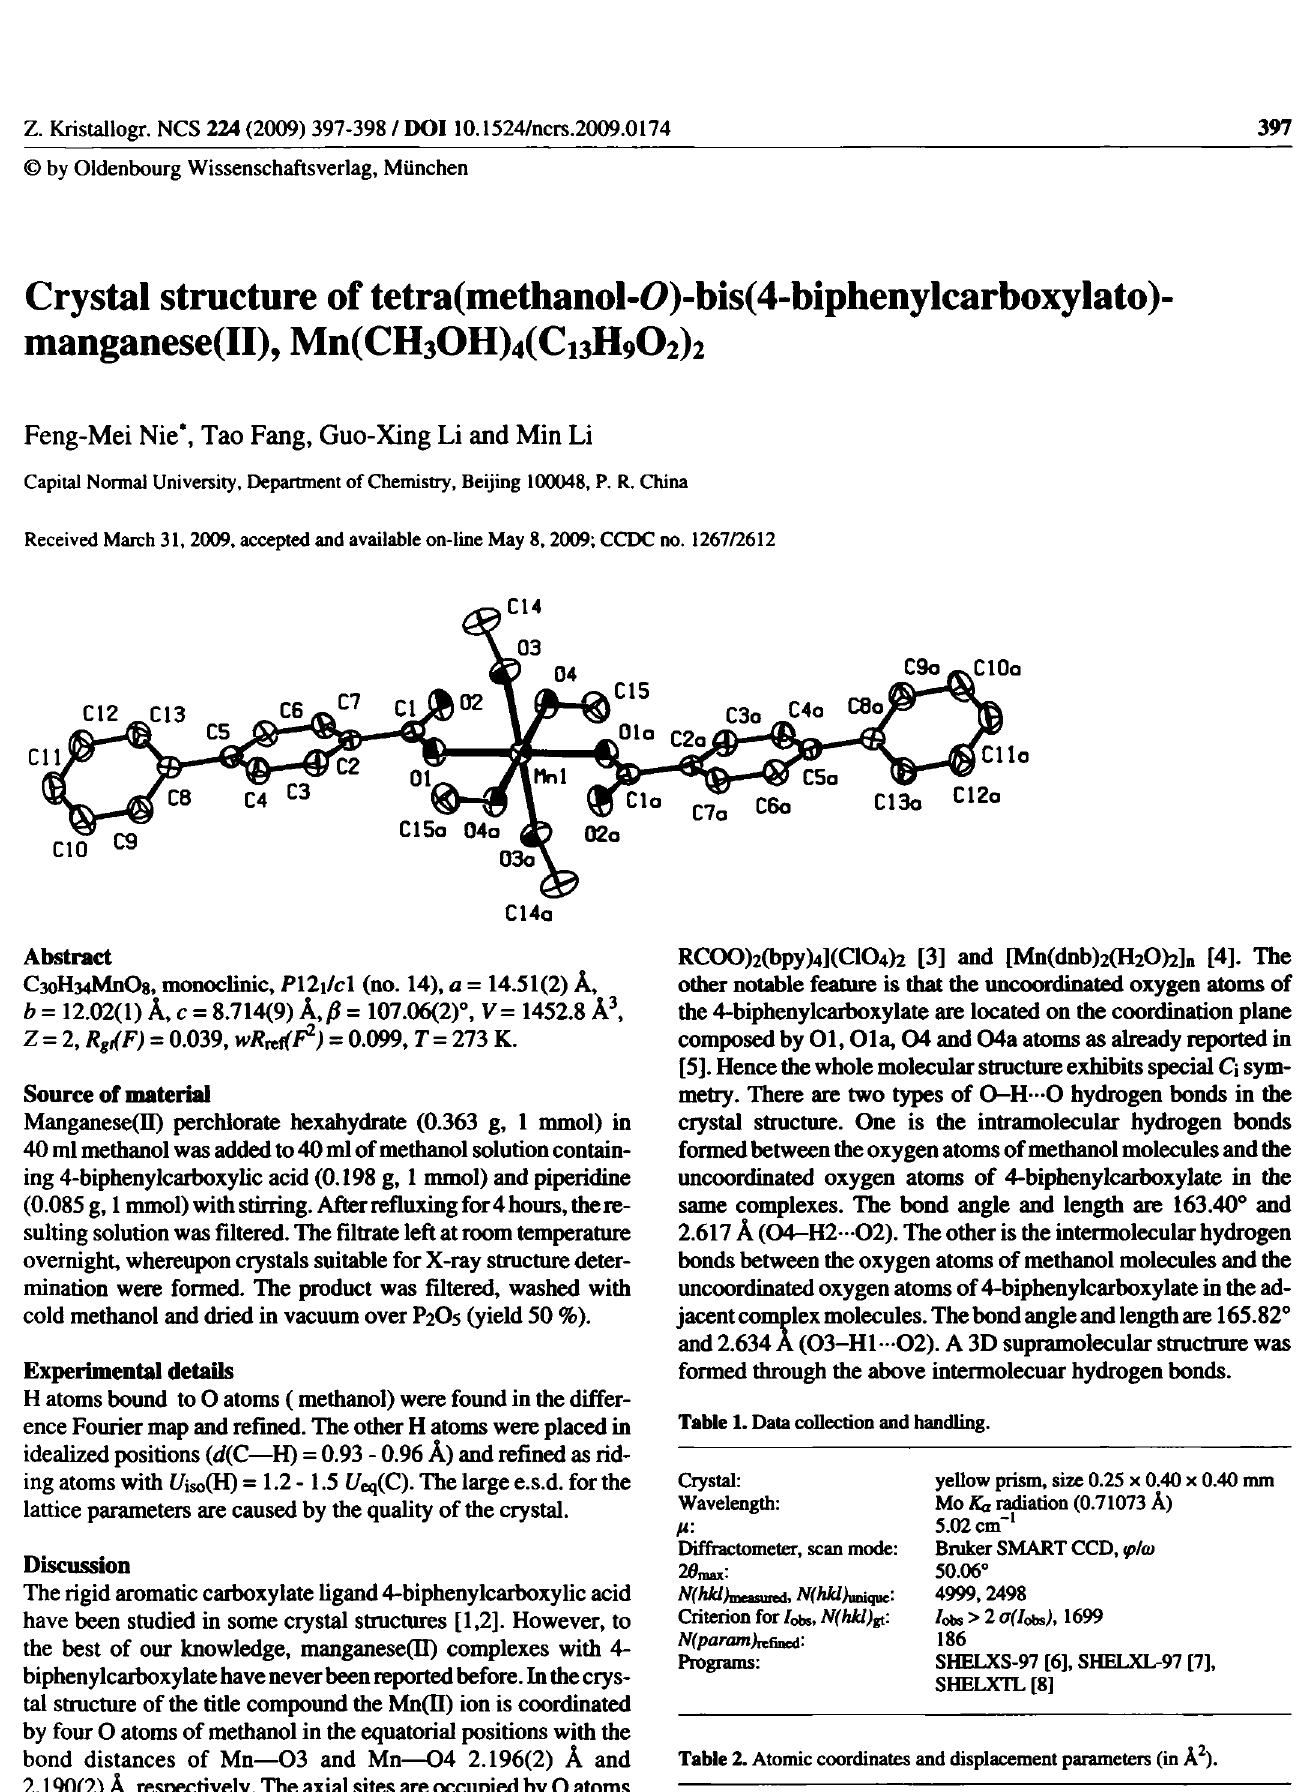
Table 2. Atomic coordinates and displacement parameters (in À 2